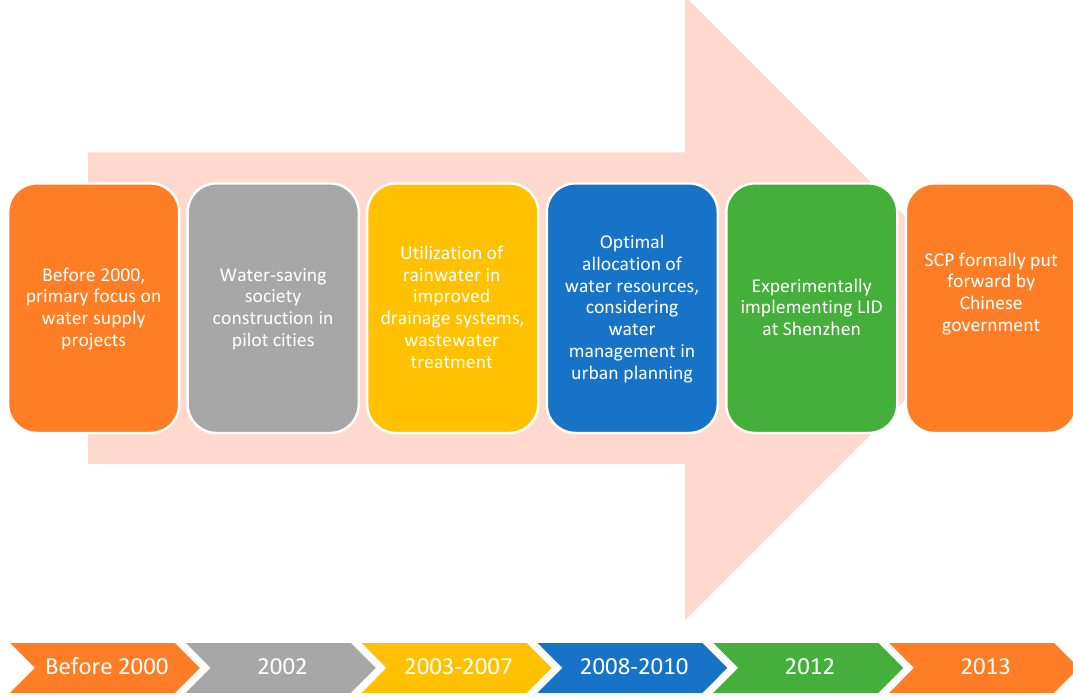
Figure 1. The urban water management policies in China from before 2000 to present. Source: authors.